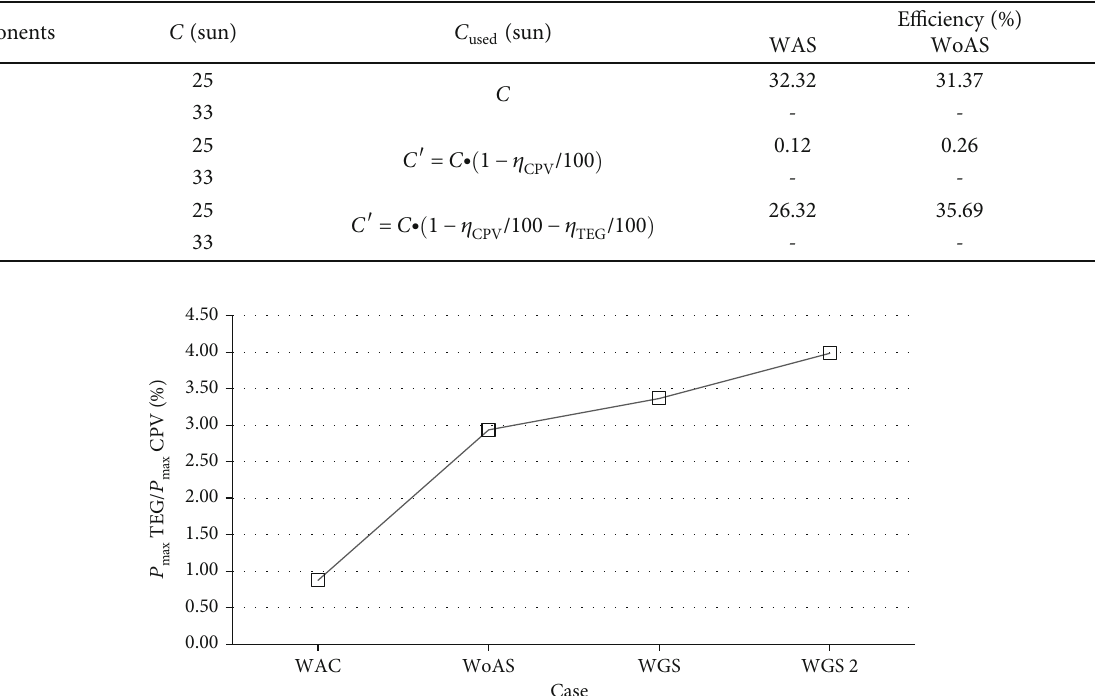
Figure 13: The variation of the temperature di ff erence for STC. Table 2: The e ffi ciencies of the HS components in the three cases considered.